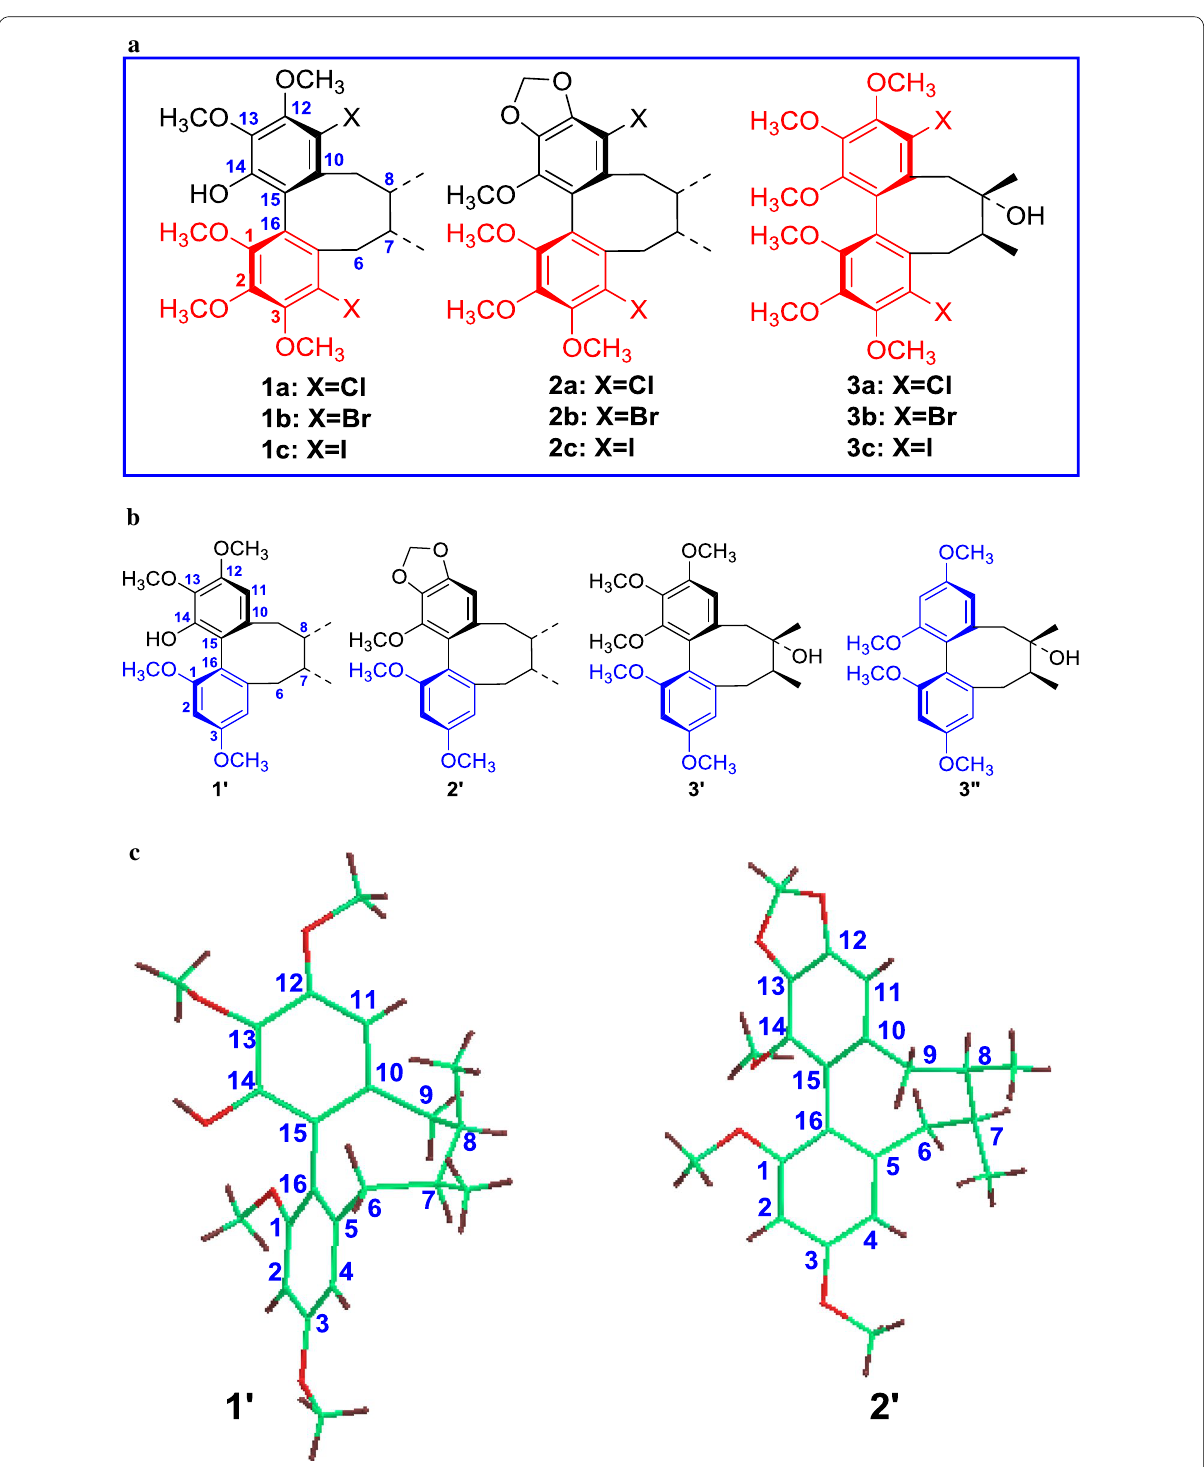
Fig. 1 a Structures of compounds 1a – 1c , 2a – 2c and 3a – 3c ; b molecular structures of compounds 1 ′ – 3 ′ and 3 ″ prepared in Na/t‑BuOH; c the single‑crystal X‑ray structures compounds 1 ′ ‑ 2